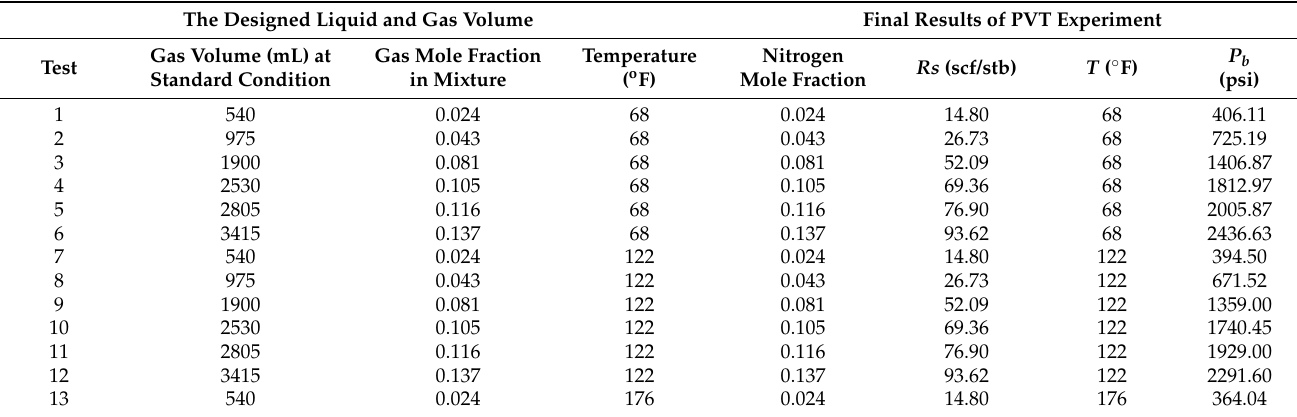
Table A2. Details of experiments and the obtained